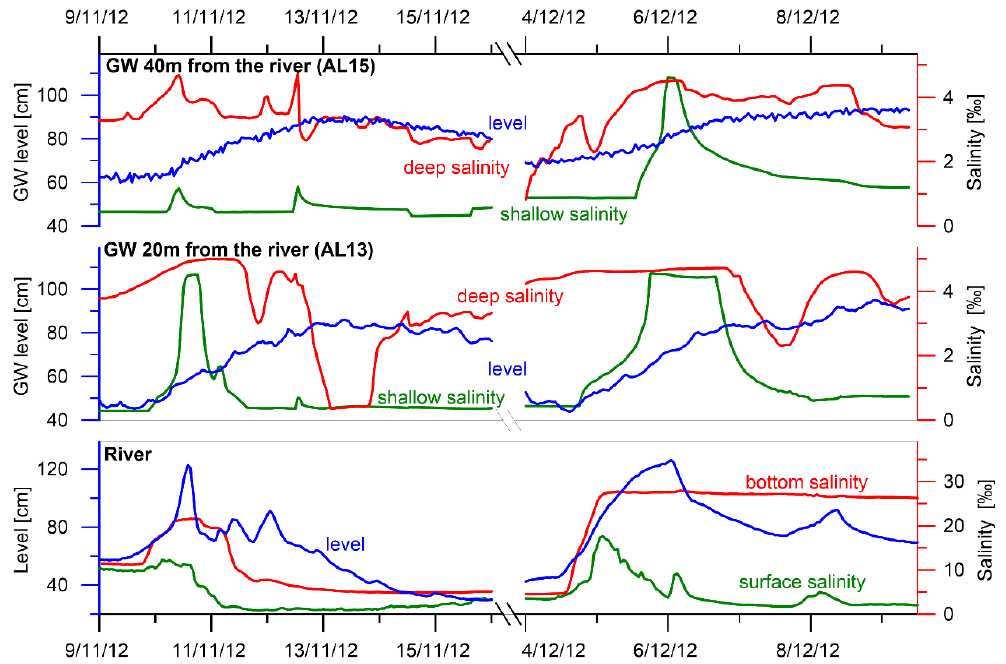
Figure 8. Enlargement of Figure 7, focusing on two river events with different intensities. The first is weaker with a relatively sharp peak and a weak increase in salinity, while the second retains high water level and salinity for several days.